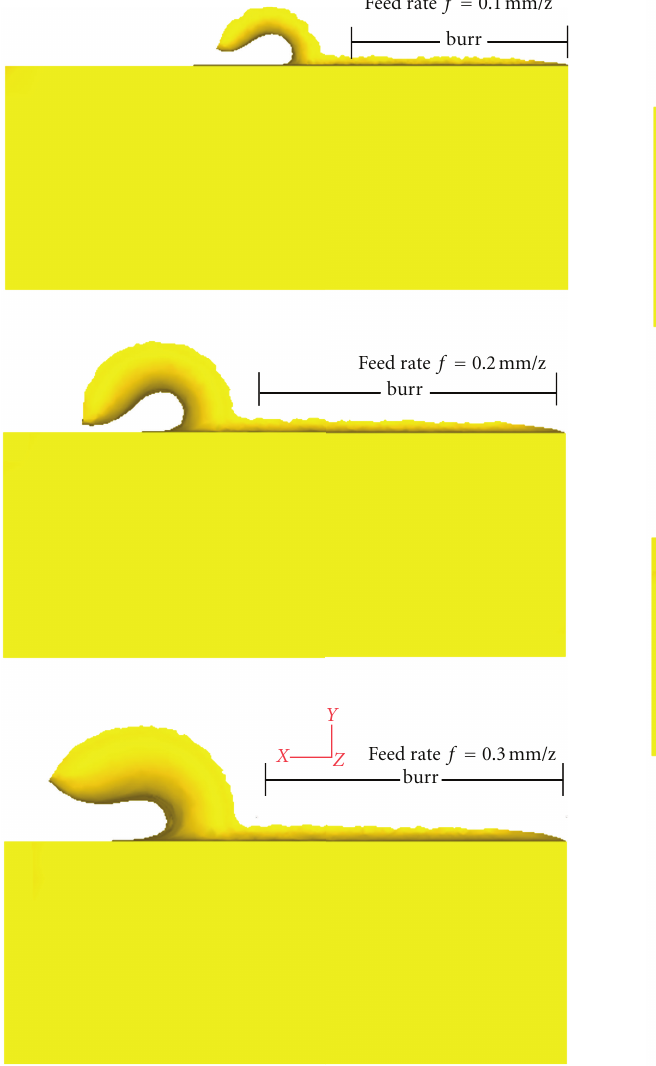
Figure 8: Burr profiles for di ff erent feed rate. and is defined as the angle between the cutting velocity vector in orthogonal cutting and tool minor cutting edge plane.